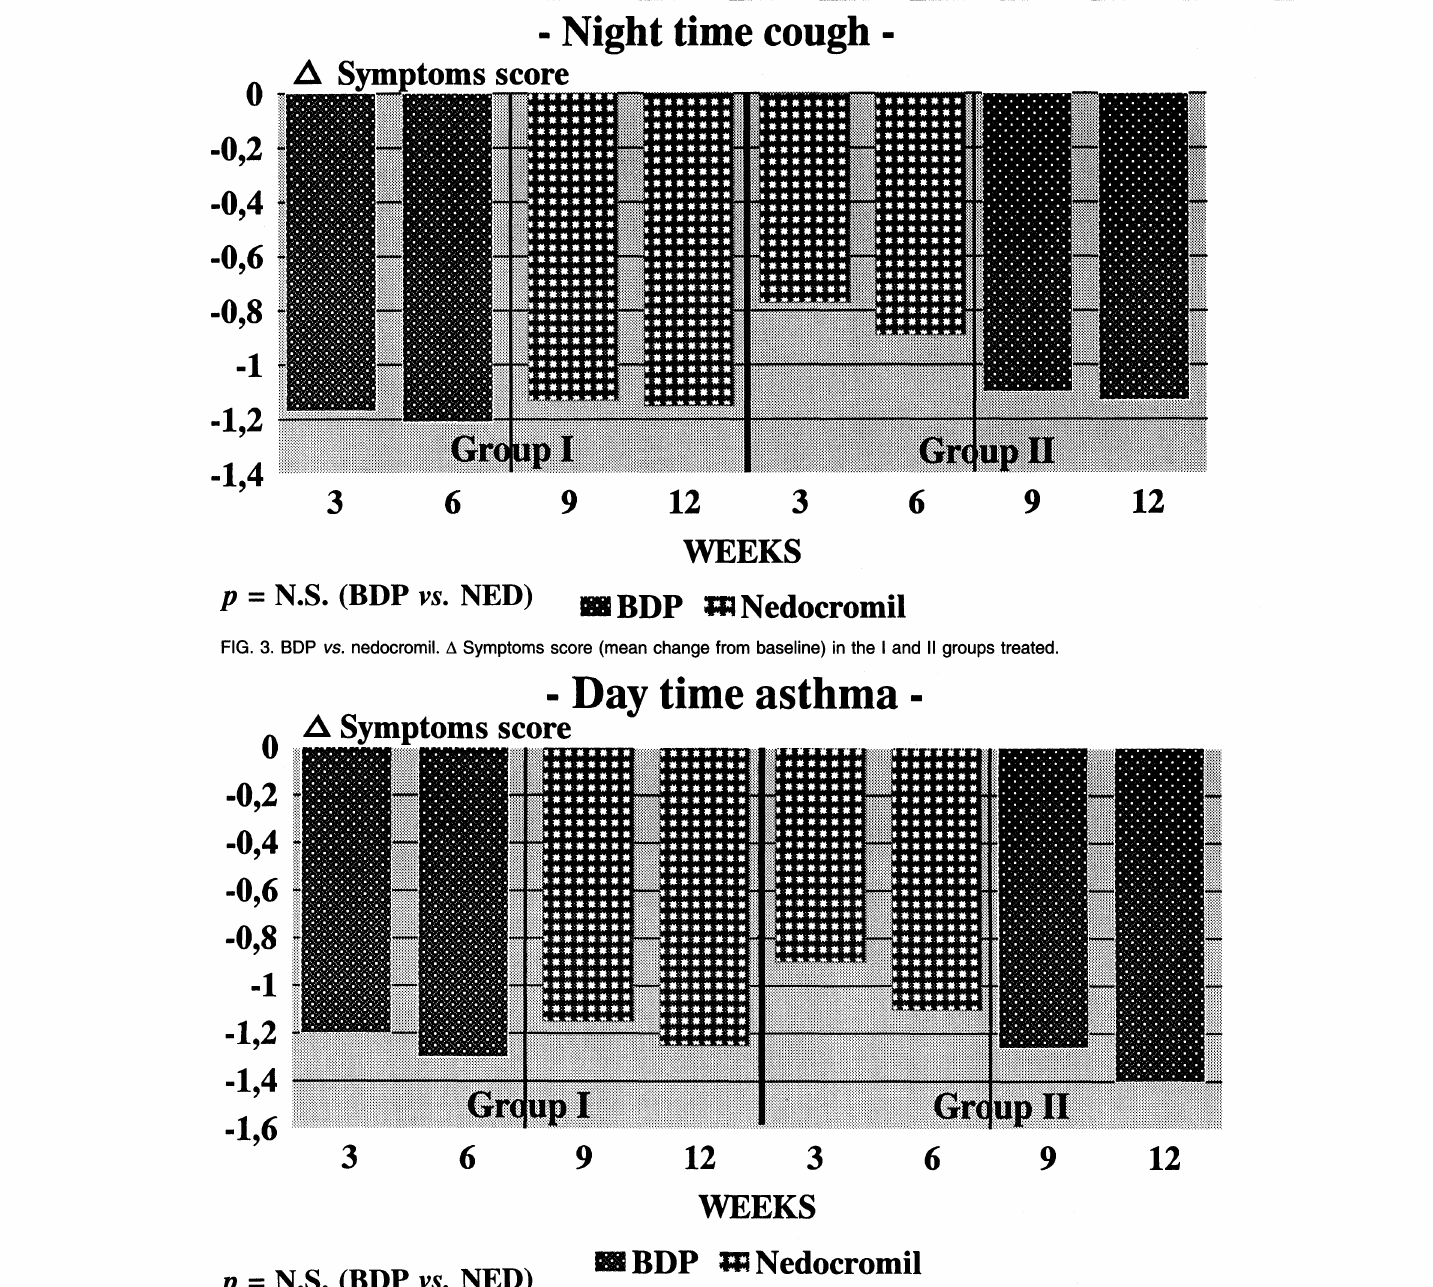
FIG. 3. BDP vs. nedocromil. A Symptoms score (mean change from baseline) in the and groups treated.